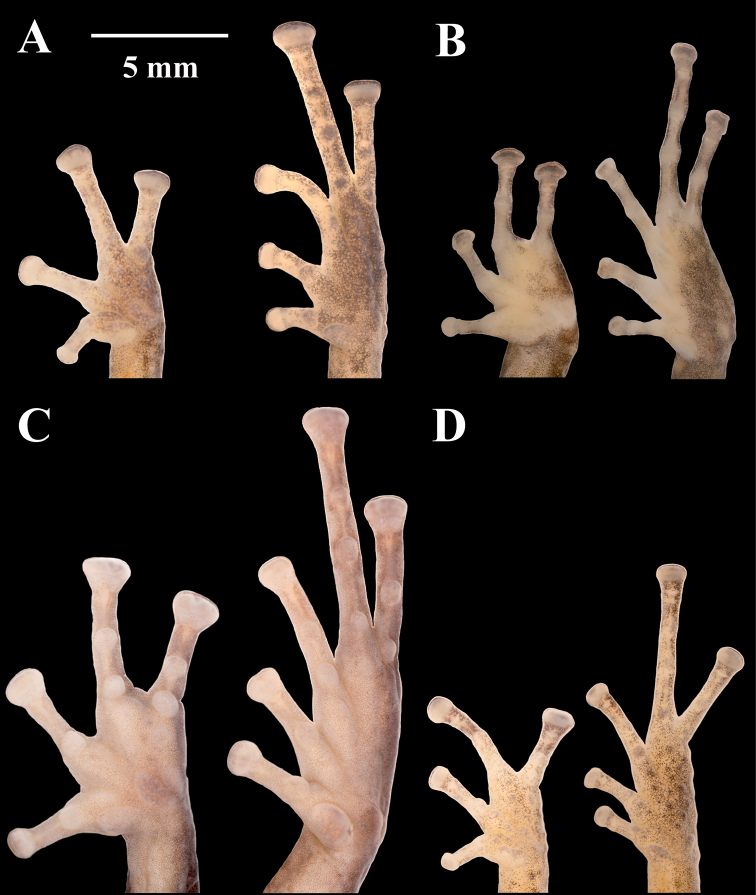
Palmar and plantar surfaces of Pristimantis
atillo sp. nov., Pristimantis
chomskyi sp. nov., Pristimantis
gloria sp. nov., and Pristimantis
jimenezi sp. nov. Photographs of left hand and foot of the holotypes APristimantis
atillo sp. nov.: QCAZ 42500, male BPristimantis
chomskyi sp. nov.: QCAZ 47515, male CPristimantis
gloria sp. nov.: QCAZ 57201, female DPristimantis
jimenezi sp. nov.: QCAZ 45170, male. All specimens are shown at the same scale.